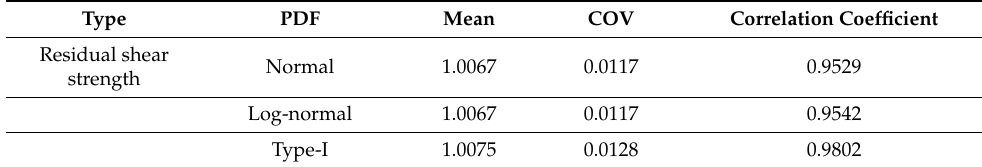
Figure 15. Bias factors of the nominal residual shear strength factor on PDF probability paper. ( a ) Normal, ( b ) Log-normal and ( c ) Type-I. Table 21. Bias factor ( B γ ) models of nominal residual strength factor.